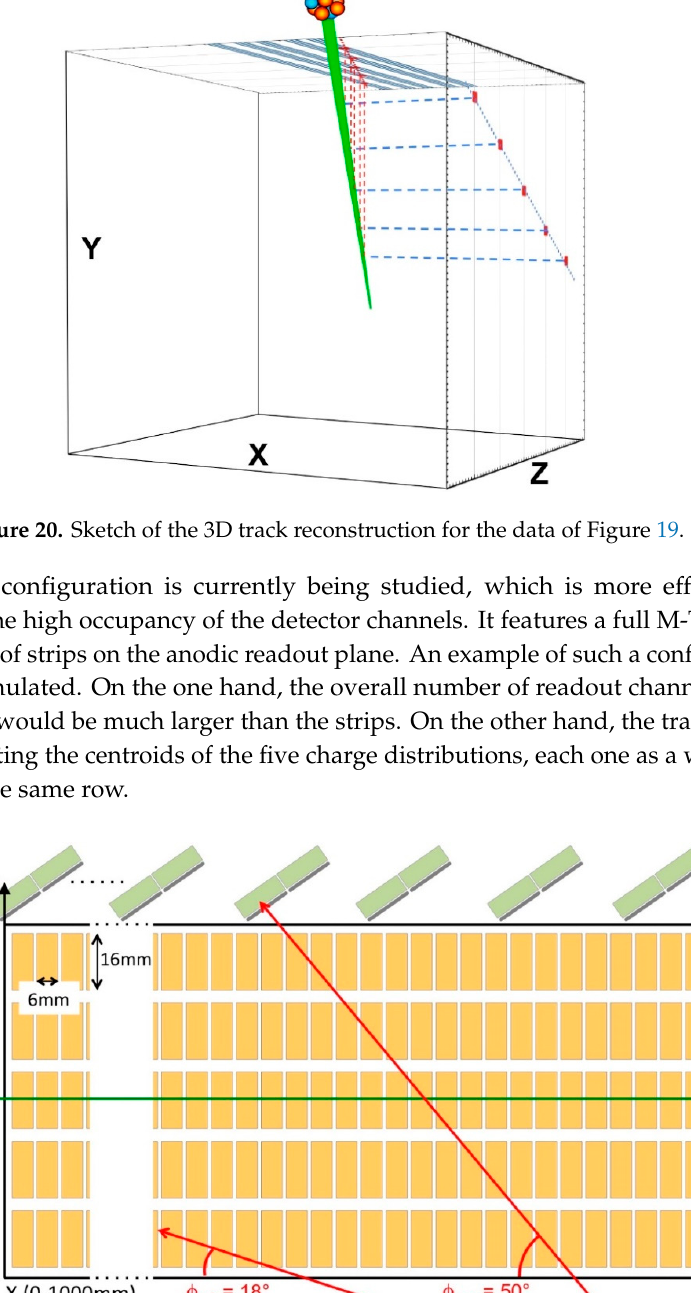
Figure 19. Example of a real track reconstruction. Left : XZ projection. Right : YZ projection.